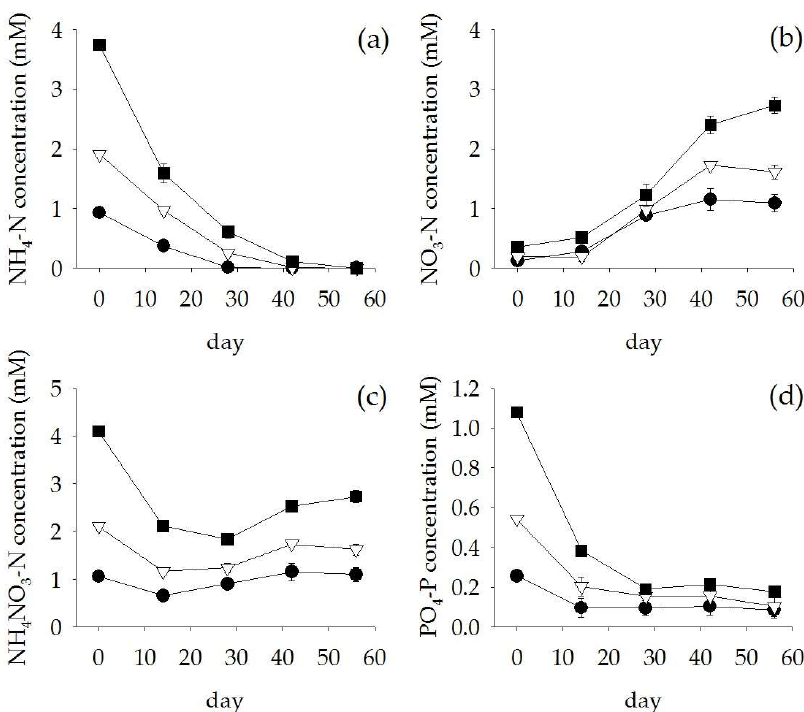
Figure 7. NH 4 -N concentration ( a ), NO 3 -N concentration ( b ), NH 4 NO 3 -N concentration ( c ), and PO 4 -P concentration ( d ) (Mean ± SE) in 25% ( ) and 50% ( ) diluted anaerobic digester effluent and 100% anaerobic digester effluent ( ) during 56 days of experiment.